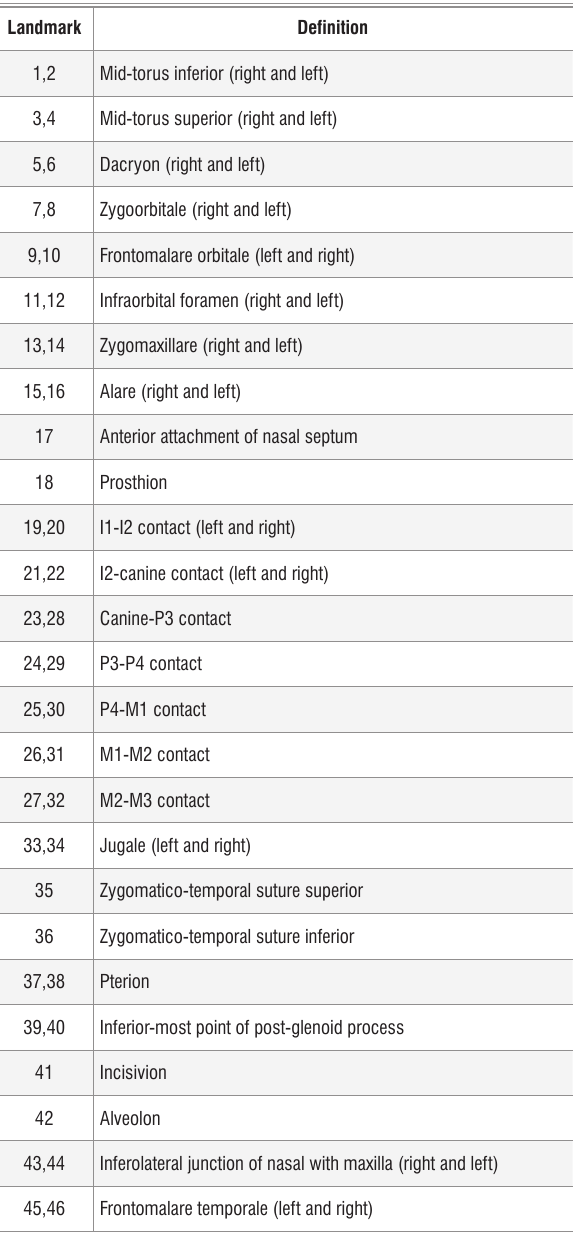
Landmark definitions for landmarks used in developmental simulation